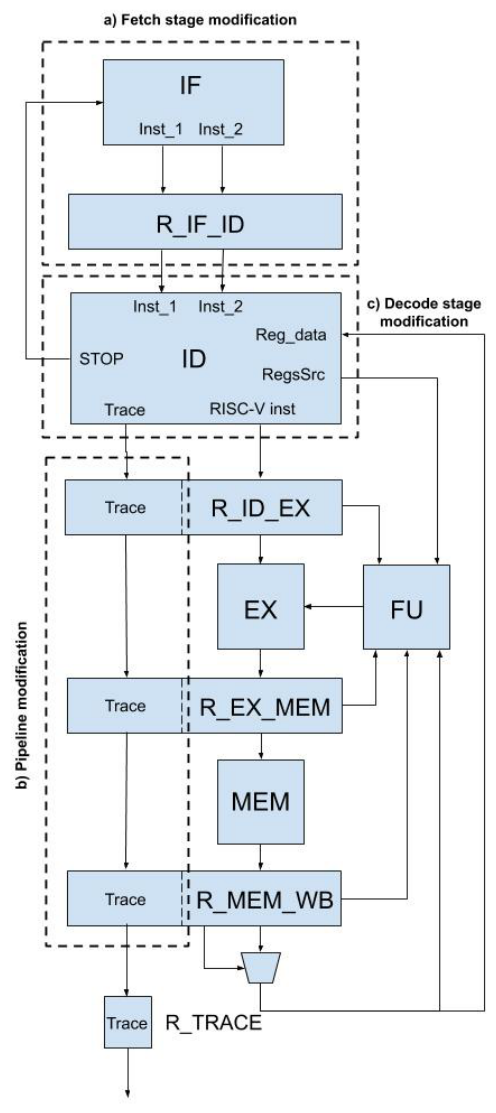
Figure 2. RV32XTrace top-level design with the following modifications: ( a ) Modified IF component